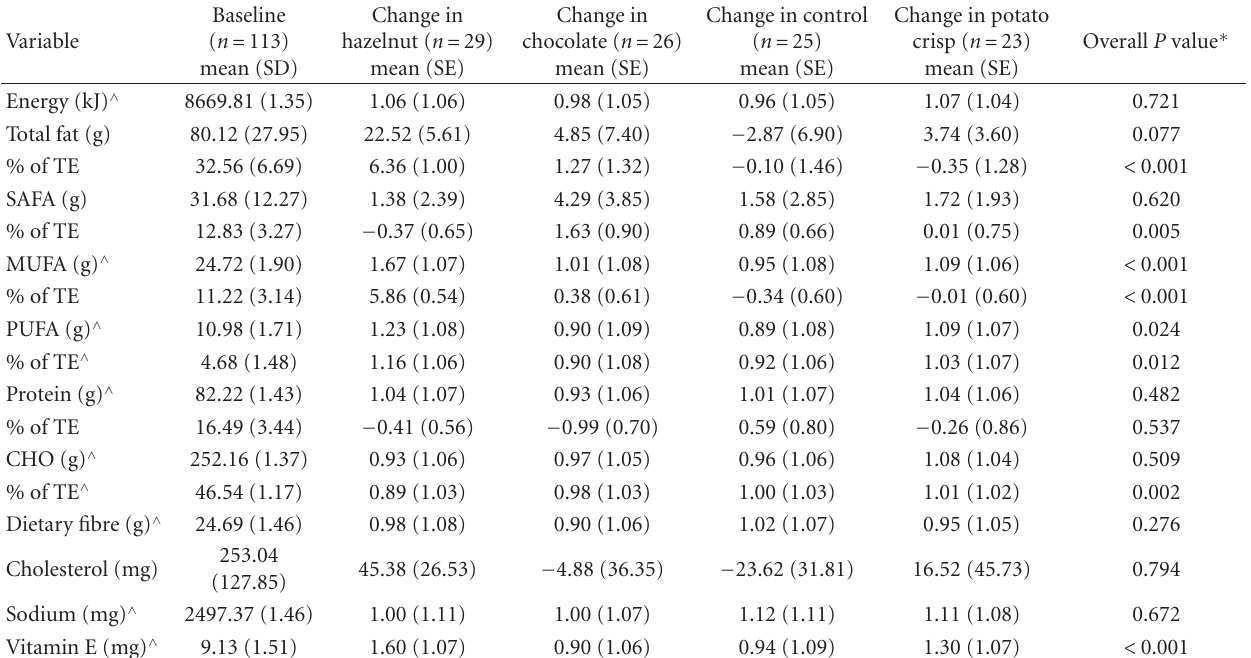
Table 2: Energy and nutrient intake at baseline and changes in intakes from baseline to week 12 for each group.